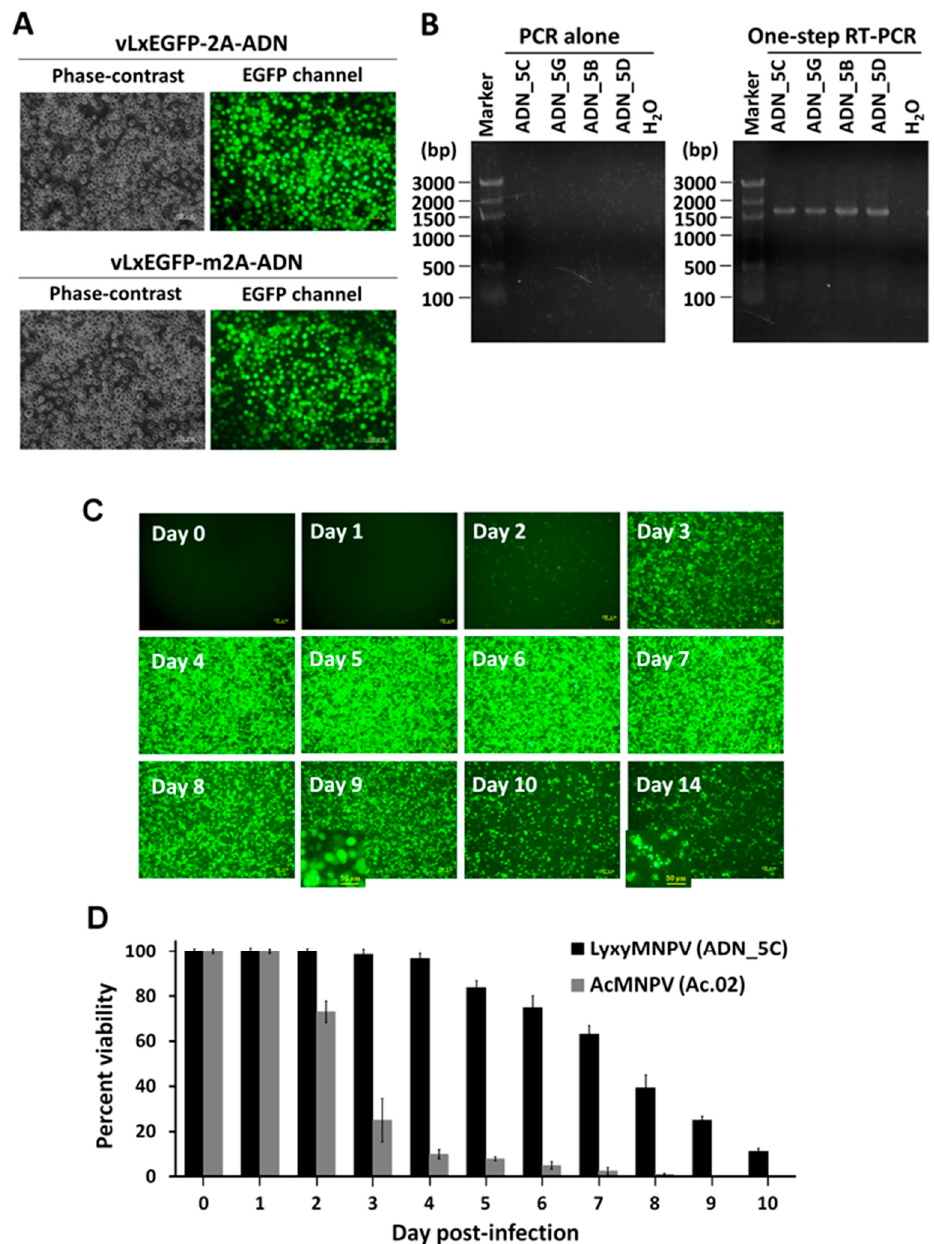
Figure 3. Recombinant virus production and cell viability analysis. ( A ) The recombinant viruses, vLxEGFP-2A-ADN and vLxEGFP-m2A-and, were generated and propagated in NTU-LY cells. The cells were inoculated with recombinant viruses at a multiplicity of infection (MOI) of 1 and incubated at 28 ◦ C. The expression of EGFP was used to monitor the viral infection in NTU-LY cells. Photographs were taken in the same field under phase-contrast microscopy, or with a GFP filter unit (Excitation: 457–487 nm, Emission: 502–538 nm) by fluorescence microscopy. Scale bar, 100 µ m. ( B ) Reverse transcription- polymerase chain reaction (RT-PCR) analysis of EGFP-2A-ADN and EGFP-m2A-ADN transcripts. PCR ( left ) and one-step RT-PCR ( right ) were used to analyze total RNA from cell cultures infected with one of four viral clones indicated at the top. ADN_5C and ADN_5G represent vLxEGFP-2A-ADN clones; ADN_5B and ADN_5D represent vLxEGFP-m2A-ADN clones. All samples were treated with DNase I ( + ). Sizes (bp) of marker DNAs are indicated on the left. ( C ) Fluorescent images and ( D ) cell viability for NTU-LY cells infected with vLxEGFP-2A-ADN at a MOI of 5 are shown for days 1–10 post-infection. Local enlarged images are presented to show the cell integrity. A conventional AcMNPV expression system is used for comparison (data from the literature [5]).